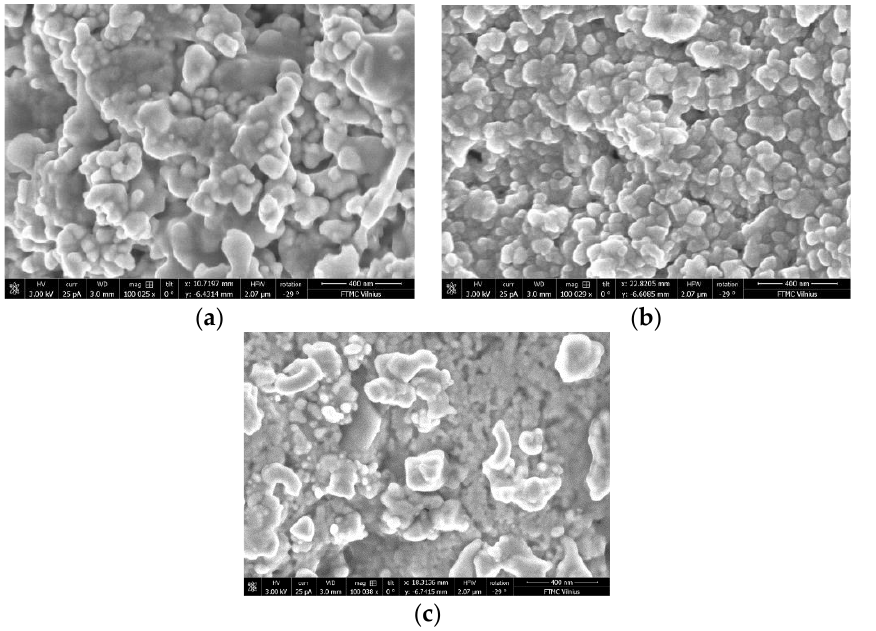
Figure 1. SEM images of phosphate ceramics samples with Ag inclusions of different size and concentrations: ( a ) 50 wt.% of 30–50 nm nanoparticles, ( b ) 30 wt.% of 80–100 nm nanoparticles, ( c ) 50 wt.% of 80–100 nm nanoparticles.